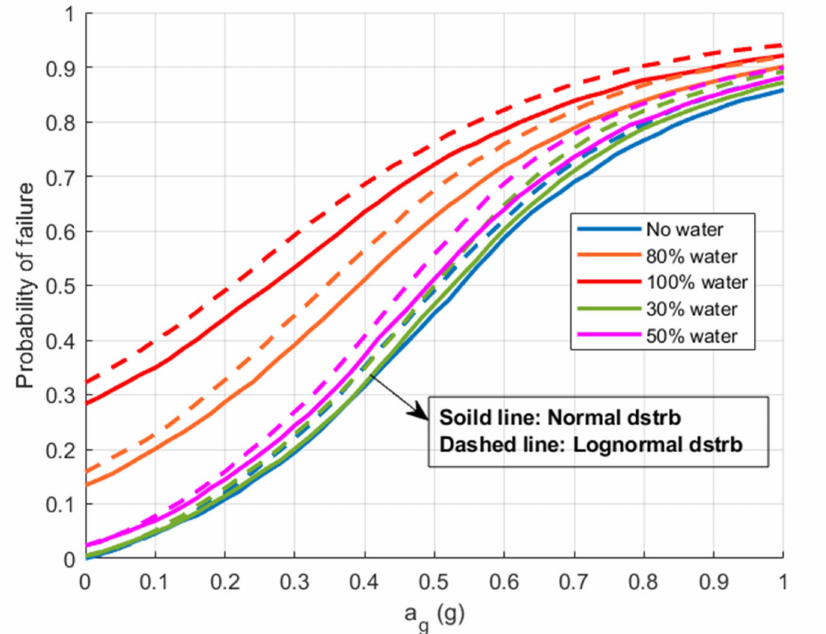
Figure 11. Fragility curves of rock slope wedge sliding for the island of Thasos, in terms of peak ground acceleration (a g ) and percentage of fill of the discontinuities with water, for slope dip direction between 128 ◦ and 140 ◦ .